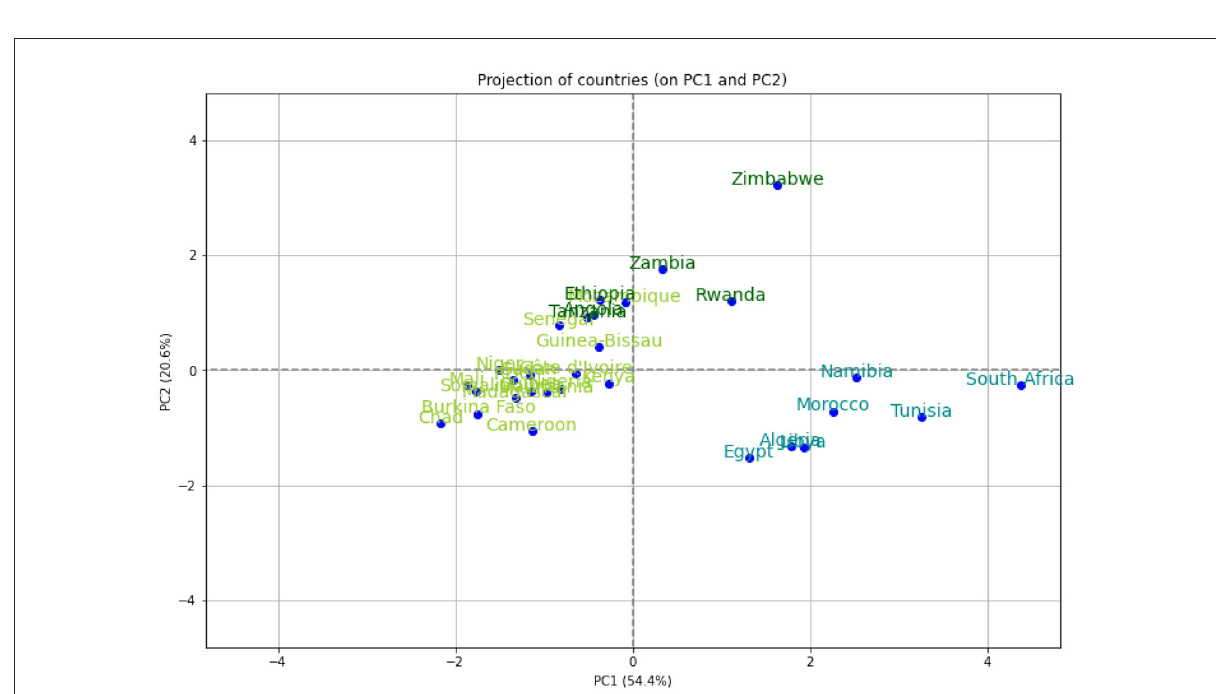
FIGURE10 Projection of the 30 African countries of the PCA’s plot on the first PC